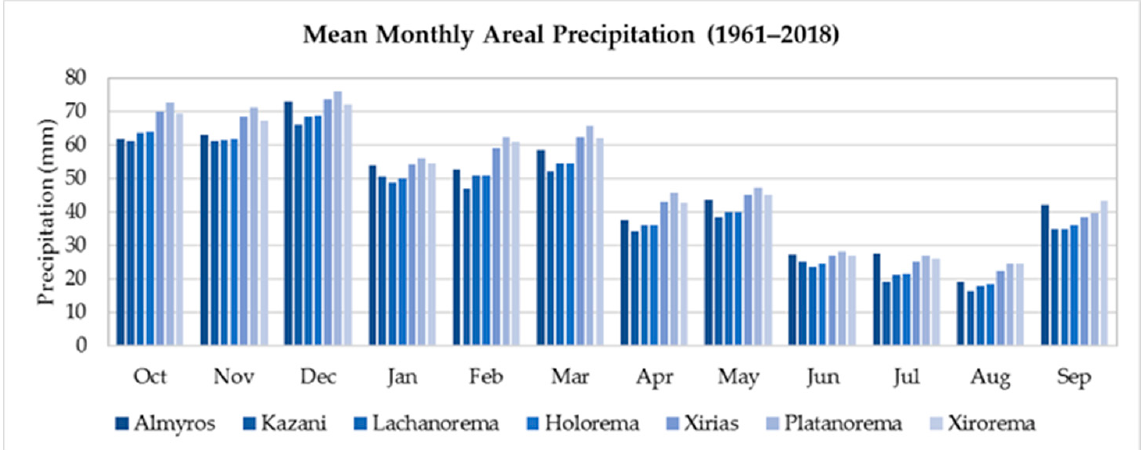
Figure 7. Mean monthly areal precipitation at the mean elevation of the Almyros basin and the sub-basins.